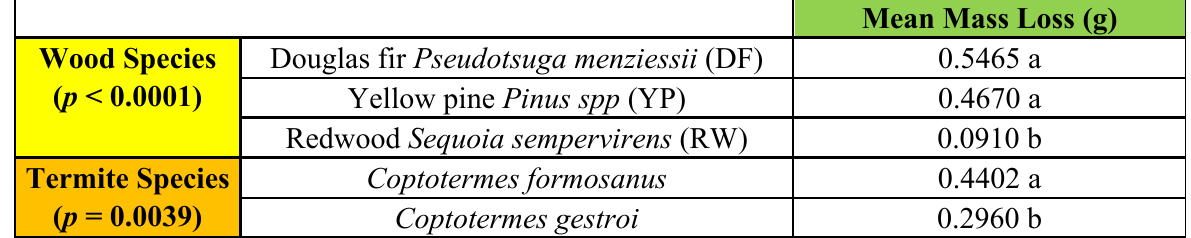
Table 2. Summary of results (Two-way ANOVA, Ryan-Einot-Gabriel-Welsch Multiple Range Test [REGWQ]) (SAS